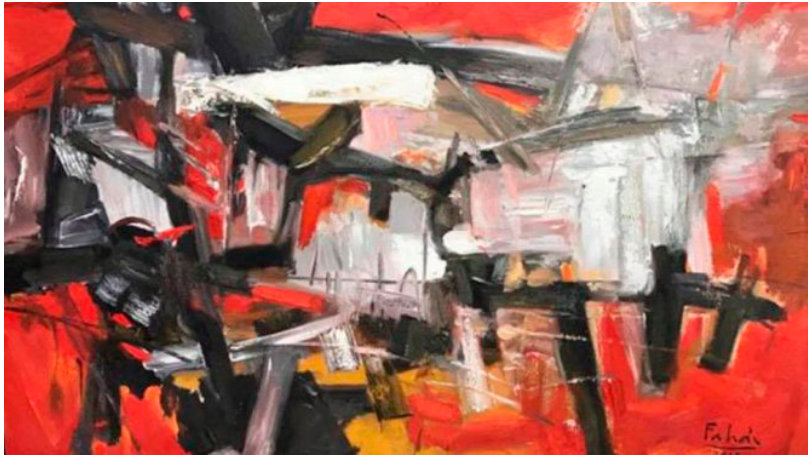
Figure 4. Fake Pham An Hai’s Du am pho co . The image was sourced from Tuoi Tre Newspaper Thi Minh (Viet 2017).